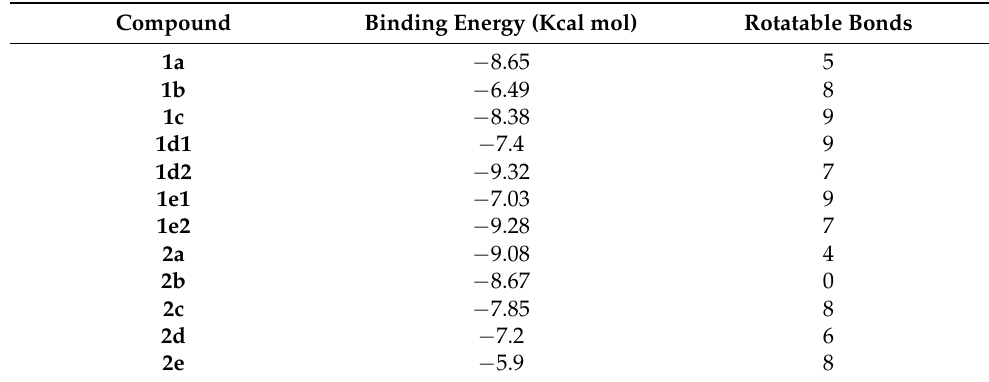
Figure 10. The rotatable bonds effect on the binding energy of gyrase B-inhibitor complex. Table 1. Binding energy of the two series gyrase B inhibitors.